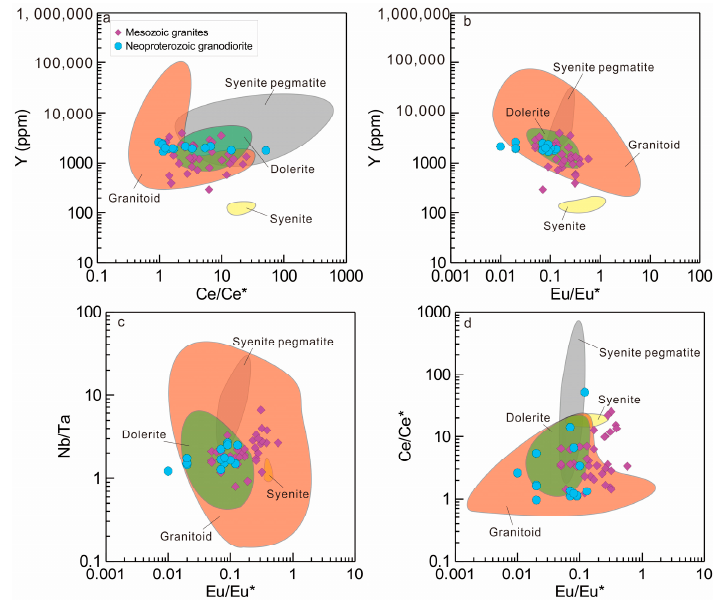
Figure 12. Zircon trace element correlations for the Shimensi granodiorite. Data of the ore-related Mesozoic Shimensi granites are from Wei et al. [6]. Data of the zircons from different igneous rock types are from [49].